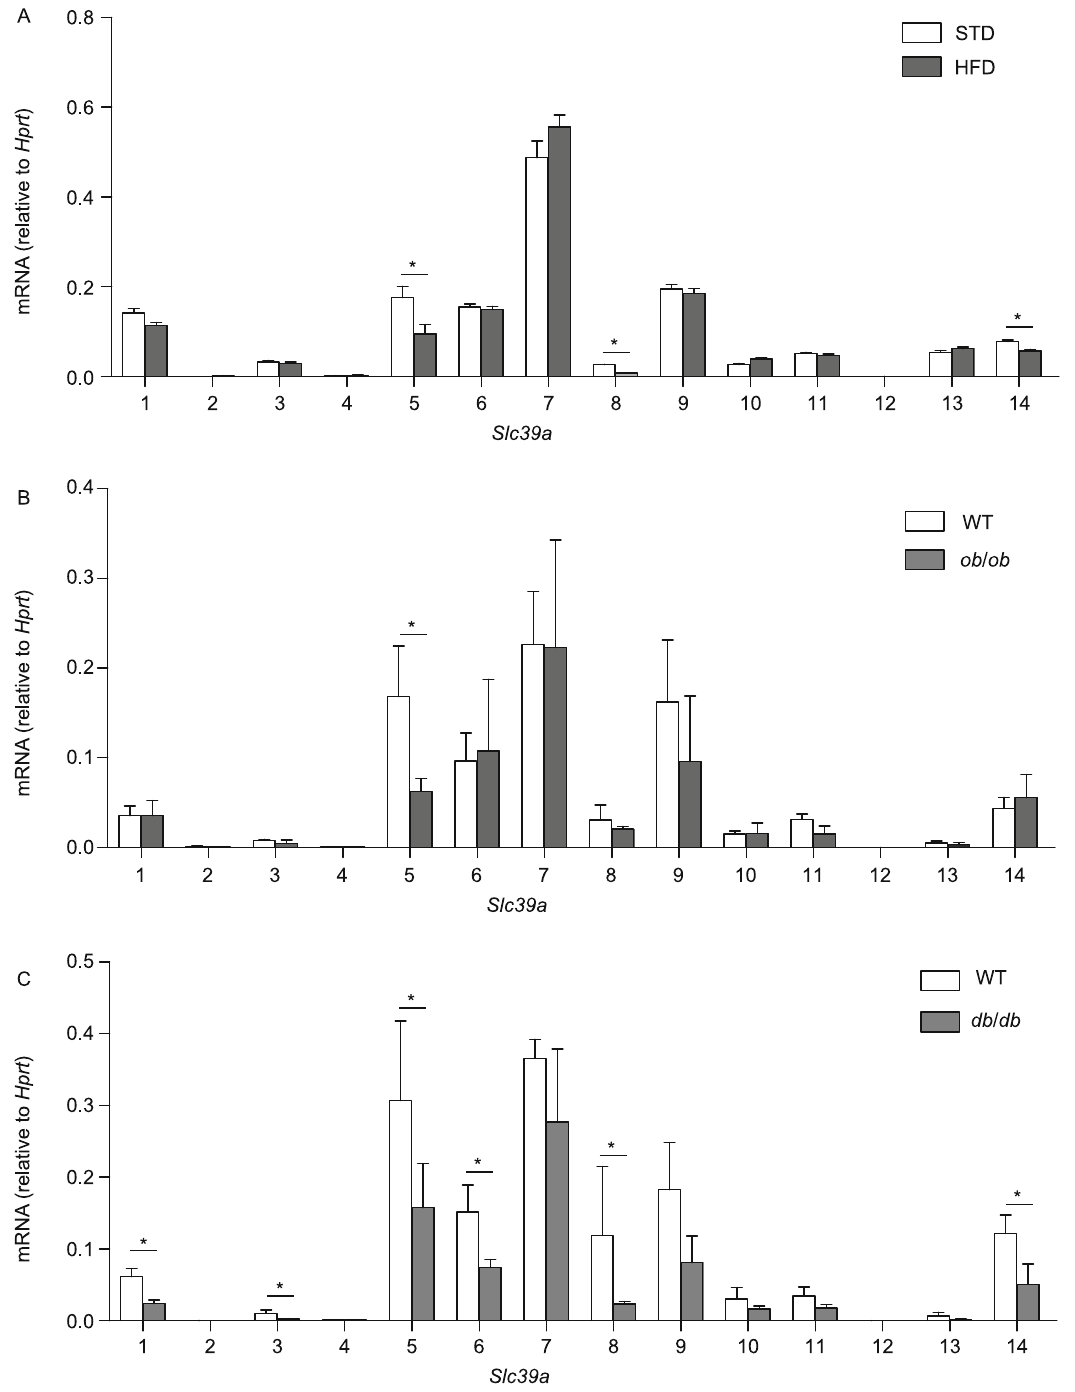
Figure 1. Summary of mRNA levels of all Slc39a gene family members measured in pancreatic islets isolated from HFD-fed, ob / ob and db / db mice. The mRNA levels of all 14 Slc39a genes were measured in pancreatic islets isolated from wild-type mice fed either a standard chow diet (STD) or a HFD (A), wild-type and ob / ob mice (B), and wild-type and db / db mice (C); n = 3 mice per group. * P < 0.05 (Student ’ s t (Fig. 2E, right). Since the majority mice used in this study conducted for 2 or 12 months old mice, and CKO mice were 3 to 6 months old, we next address the possibility of showed similar phenotypes among different ages (Fig. S4). age-effect on the observed phenotypes. GTT has been Taken together, these results show that β -cell-speci fi c